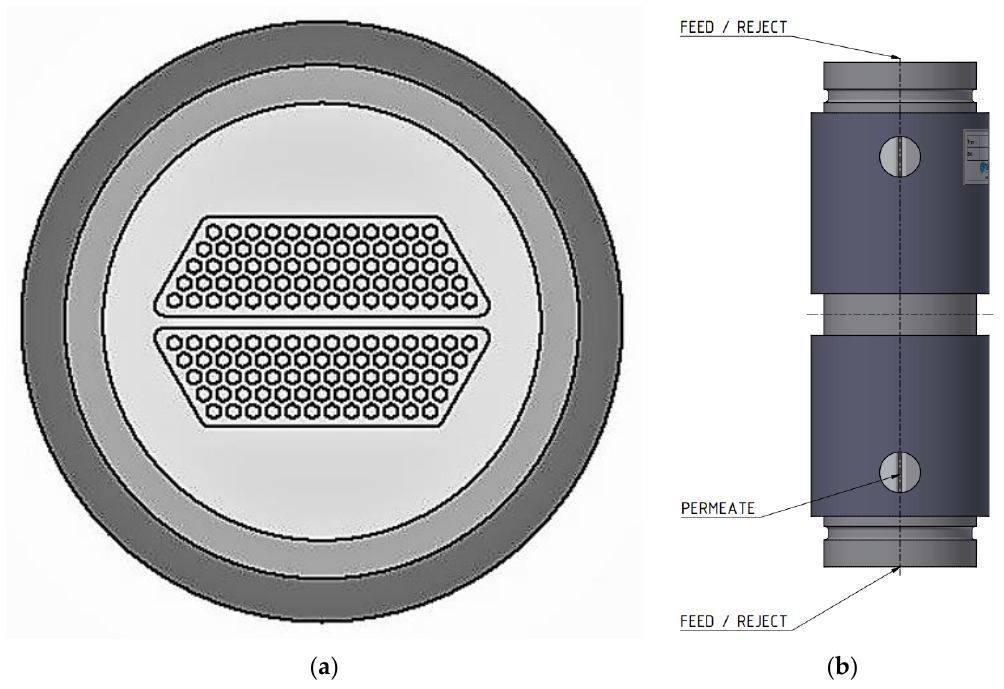
Figure 3. ( a ) Multi-channel ceramic membrane module cross-section and ( b ) multi-channel ceramic membrane module housing, indicating feed, reject, and permeate ports.